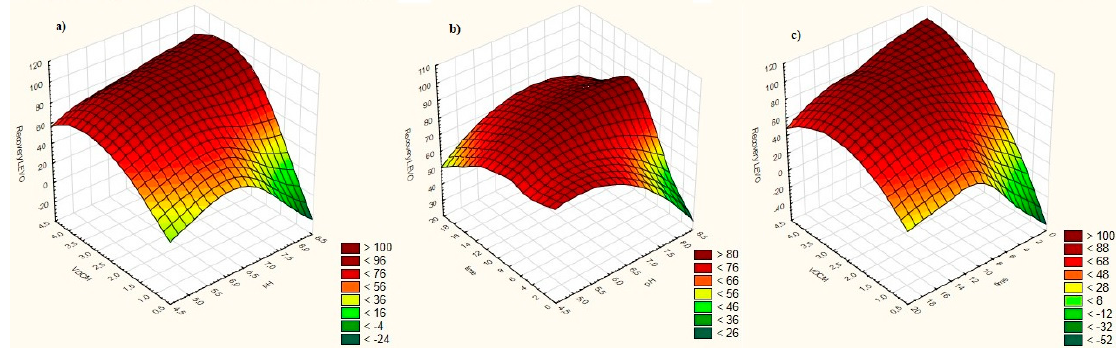
Figure 3. The RSM diagrams illustrating the change of recovery of LEVO when analyzed: ( a ) VDCM and pH; ( b ) time and pH; ( c ) time and VDCM for CCD.